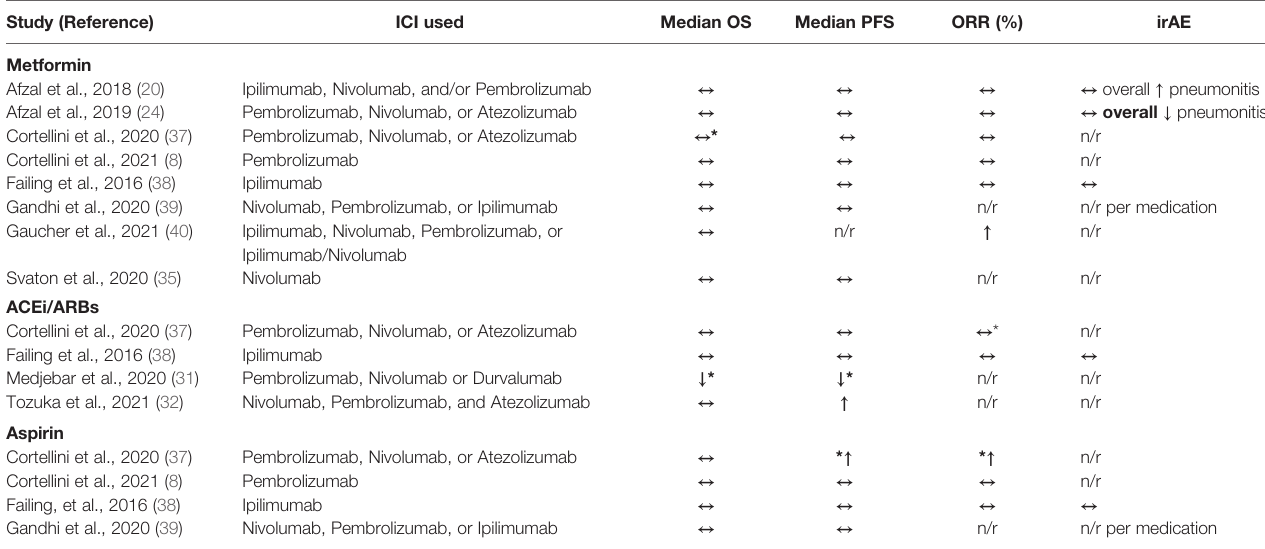
TABLE 2 | Summary of impact of concomitant medications on ICI ef fi cacy and irAE development. Study (Reference)